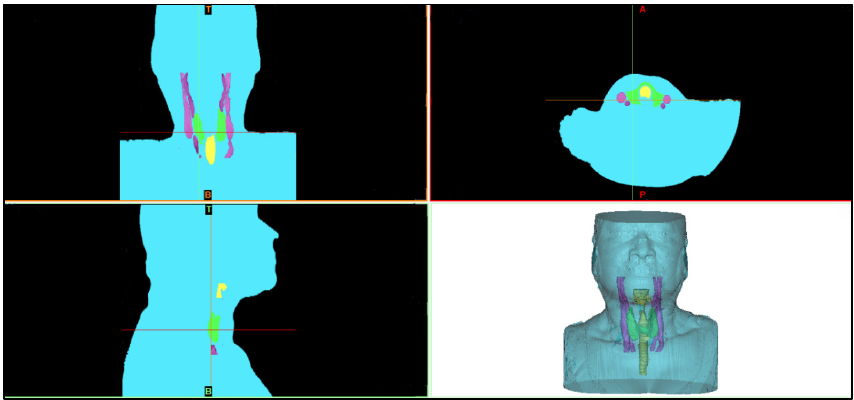
Figure 5. Visualization of the different masks (representing the different anatomic structures) and the complete segmented 3D model.